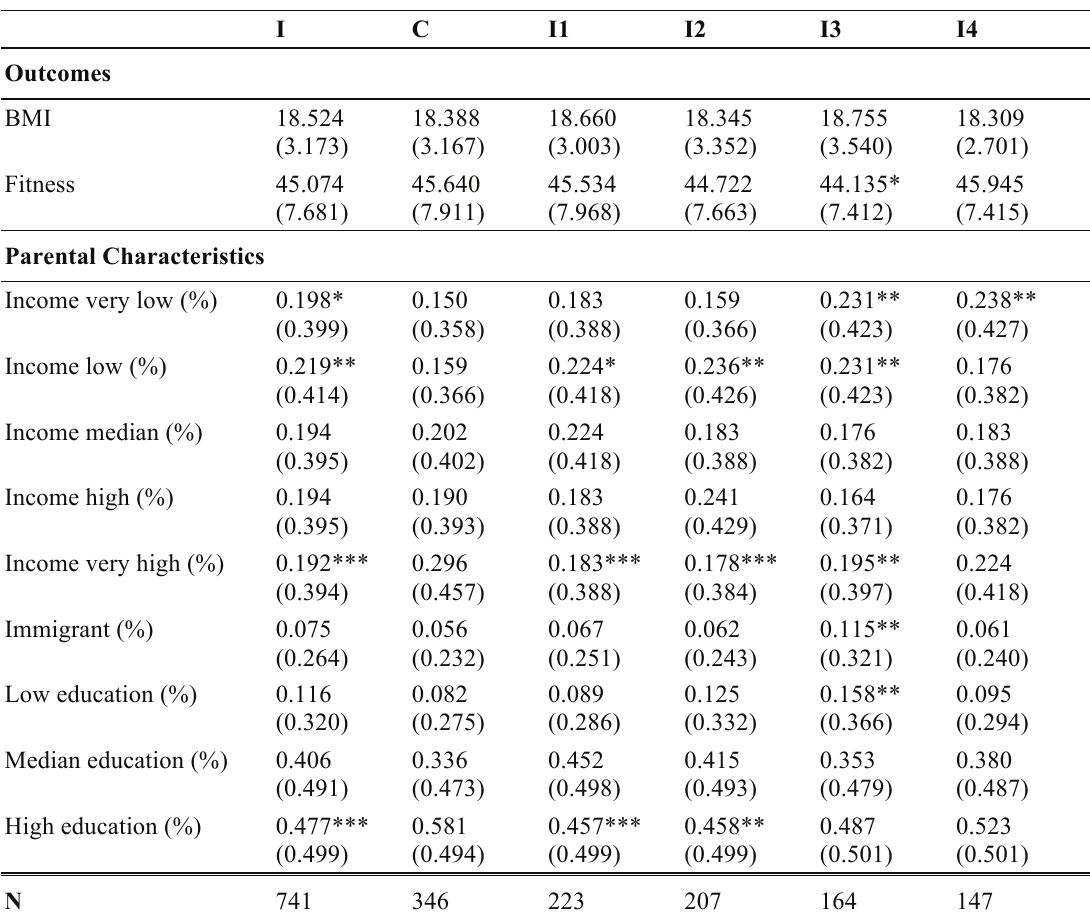
Table 1. Sample means of selected variables by control and intervention